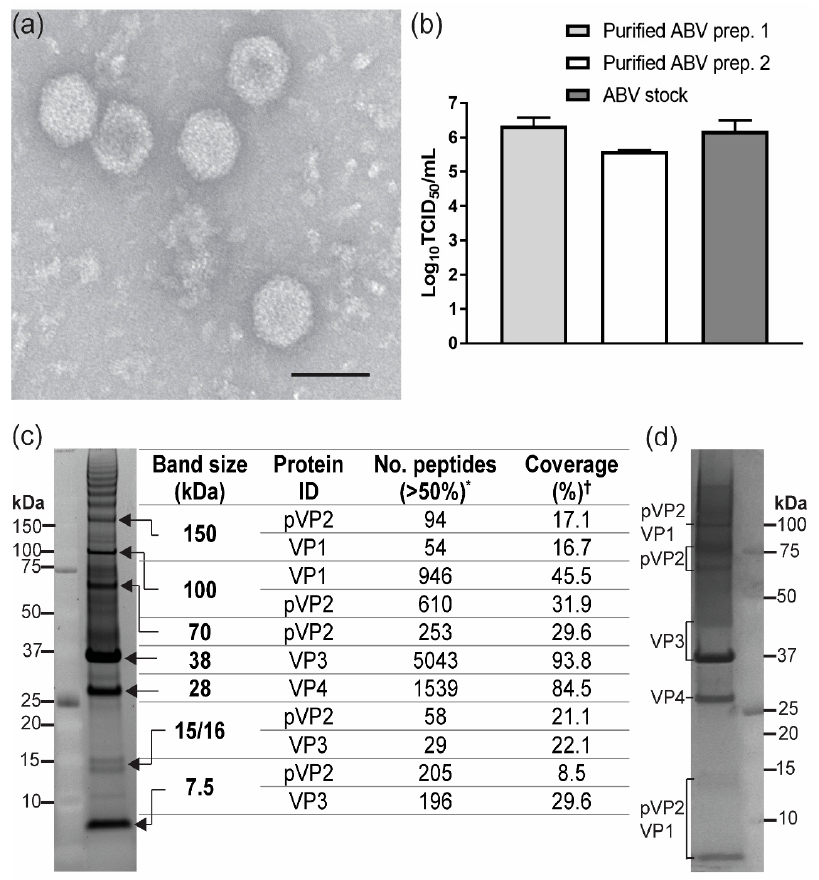
Figure 4. Protein analysis of ABV. ( a ) Transmission electron micrograph of purified ABV particles negatively stained with uranyl acetate and imaged at 200 K. Scale bar represents 100 nm. ( b ) Infectivity of two preparations of CsCl gradient-purified ABV particles in C6/36 cells as compared to ABV-infected cell supernatant used at a known MOI (0.1). Values graphed are averaged virus titers in supernatants taken from infected cells at 7 days post-infection (dpi). Error bars represent standard deviation in titers between 3 replicate wells. ( c ) Ruby stained image of SDS-PAGE analysis on purified ABV boiled and reduced with 1 M DTT, and results of mass spectrometry identification of excised protein bands as indicated by arrows. Protein ID refers to top ranking proteins identified in each band by mass spectrometry analysis. * No. peptides, number of peptides identified with equal to or greater than 50% confidence; † Coverage, percentage of protein covered by peptides identified with >50% confidence. ( d ) Ruby stained image of SDS-PAGE analysis of ABV further denatured in 3 M urea. Protein identities based on mass spectrometry are indicated next to each band. Kaleidoscope protein ladder was run alongside all samples.